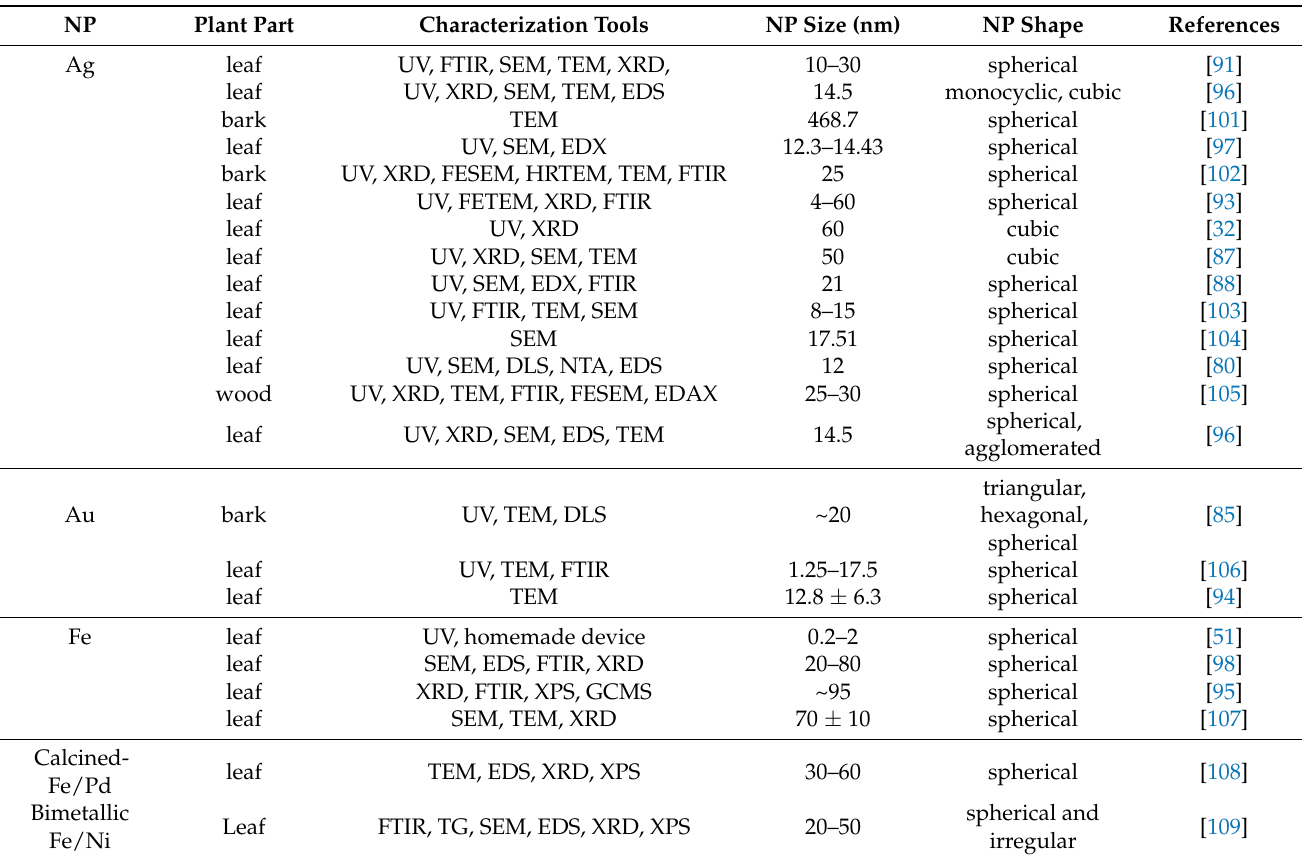
Table 1. Eucalyptus -mediated synthesis of metallic